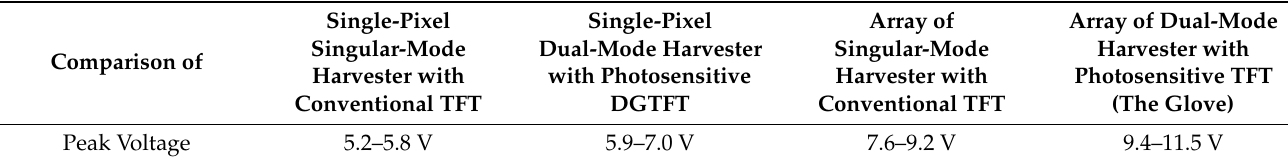
Table 3. Peak voltage extraction between harvesters with conventional and 3D photosensitive DGTFT.